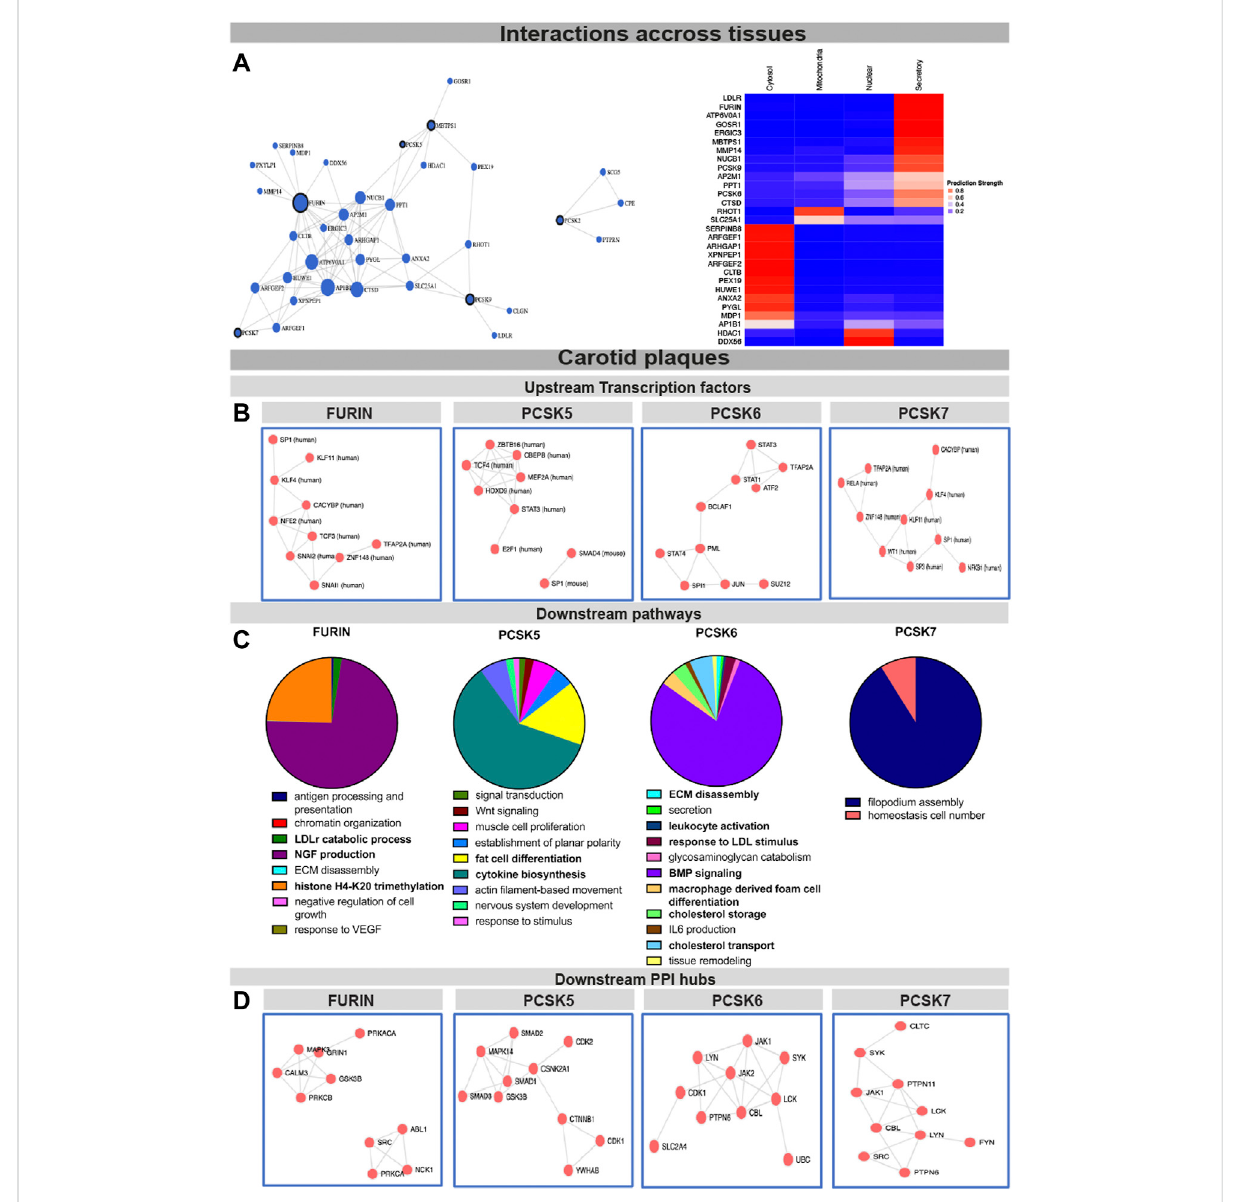
FIGURE 4 Interconnectivity and expression correlations within the PCSK family in healthy tissues and carotid plaques. Interconnectivity analysis among the nine members of the PCSK family, based on the FunCoup software. Size of the nodes corresponds to the enrichment of functional connections with other proteins in the network. Subcellular localisation of the proteins from the network was determined and plotted using SubCellBarCode (A) . Transcription factors predicted to regulatethe genes positively correlated with FURIN and PCSK5-7in carotid plaques (B) Geneset enrichment analysis of genes positively correlated with FURIN and PCSK5-7 in carotid plaques (C) . Predicted PPI hubs of genes positively correlated with FURIN and PCSK5-7 in carotid plaques (D) . Genes used for these analyses show Pearson correlation r > 0.5 to each selected PCSK. Protein-protein interaction